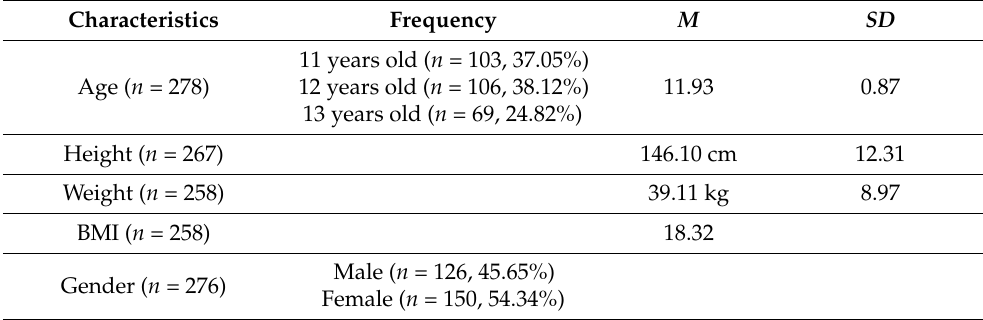
Table 1. Characteristics of Study